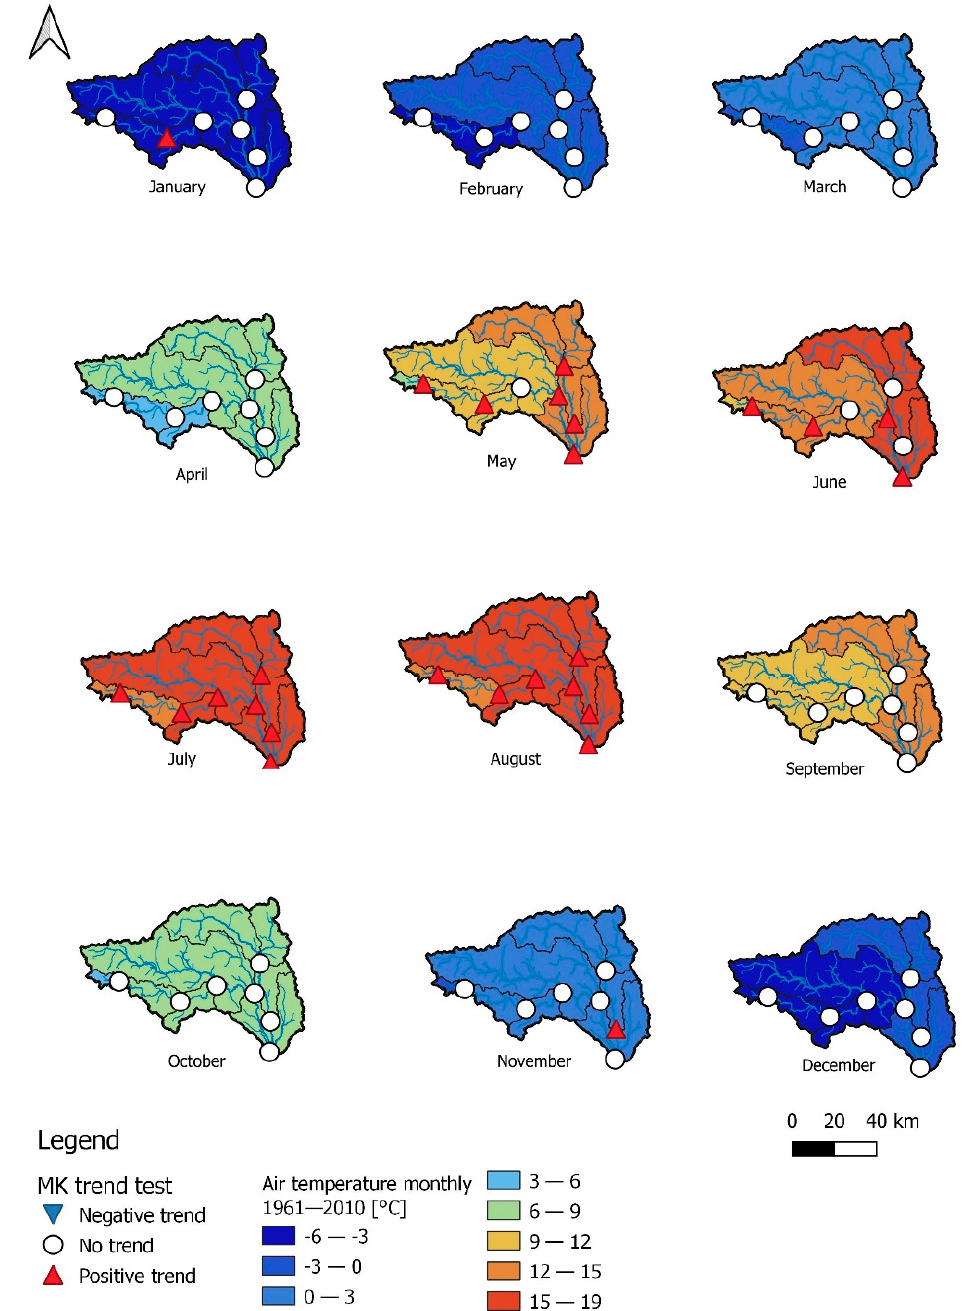
Figure 7. Monthly trends in the air temperature during the years Figure 7 Monthly trends in the air temperature during the years 1961–2010.